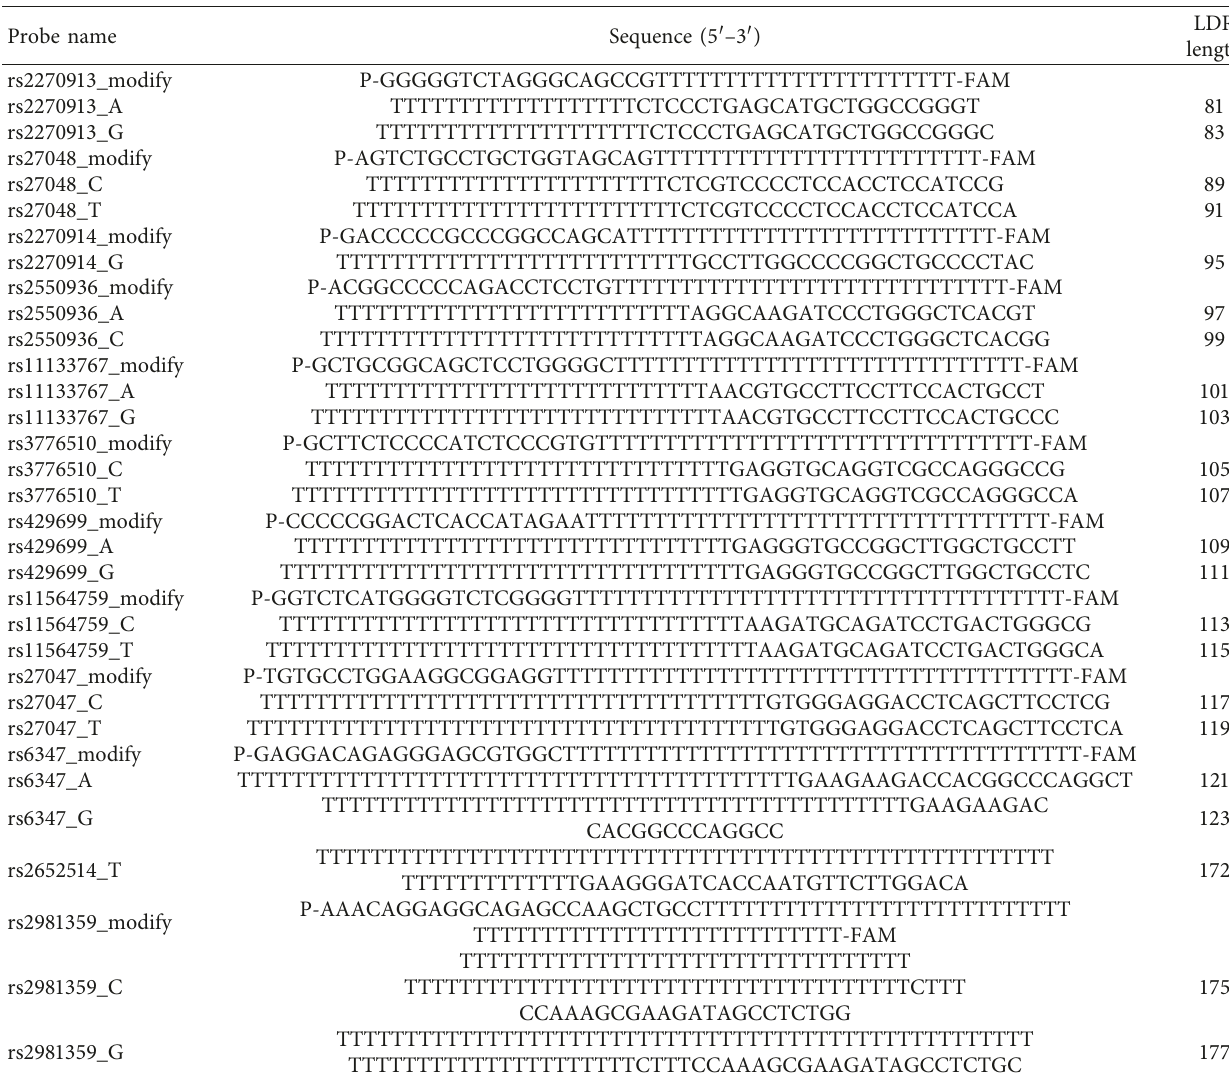
Table 2: Probe of single-nucleotide polymorphisms of